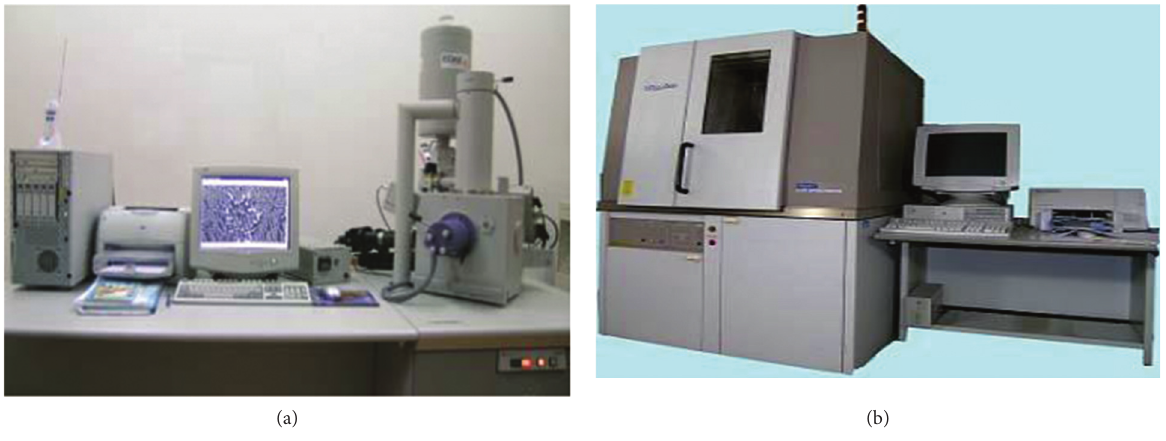
Figure 1: Morphology and phase test. (a) SEM. (b) XRD. Table 6: Rheological properties of